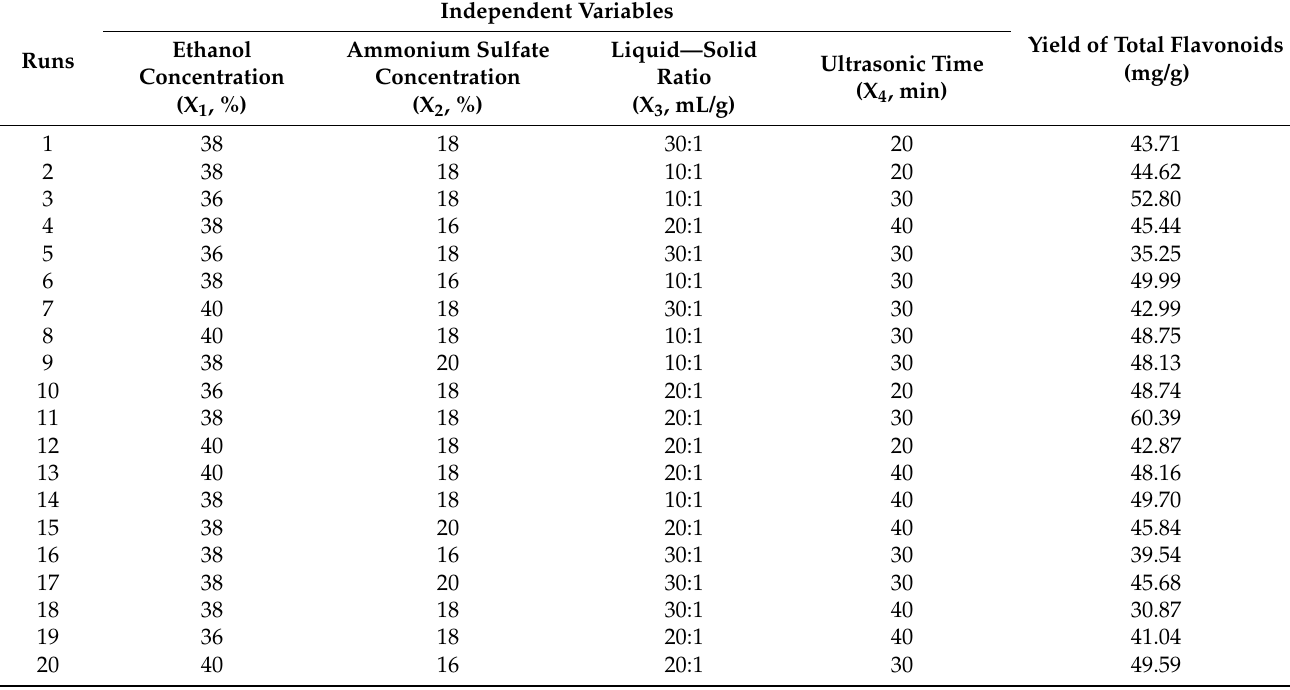
Table 3. Experimental data and total flavonoid extraction analyzed by the Box–Behnken